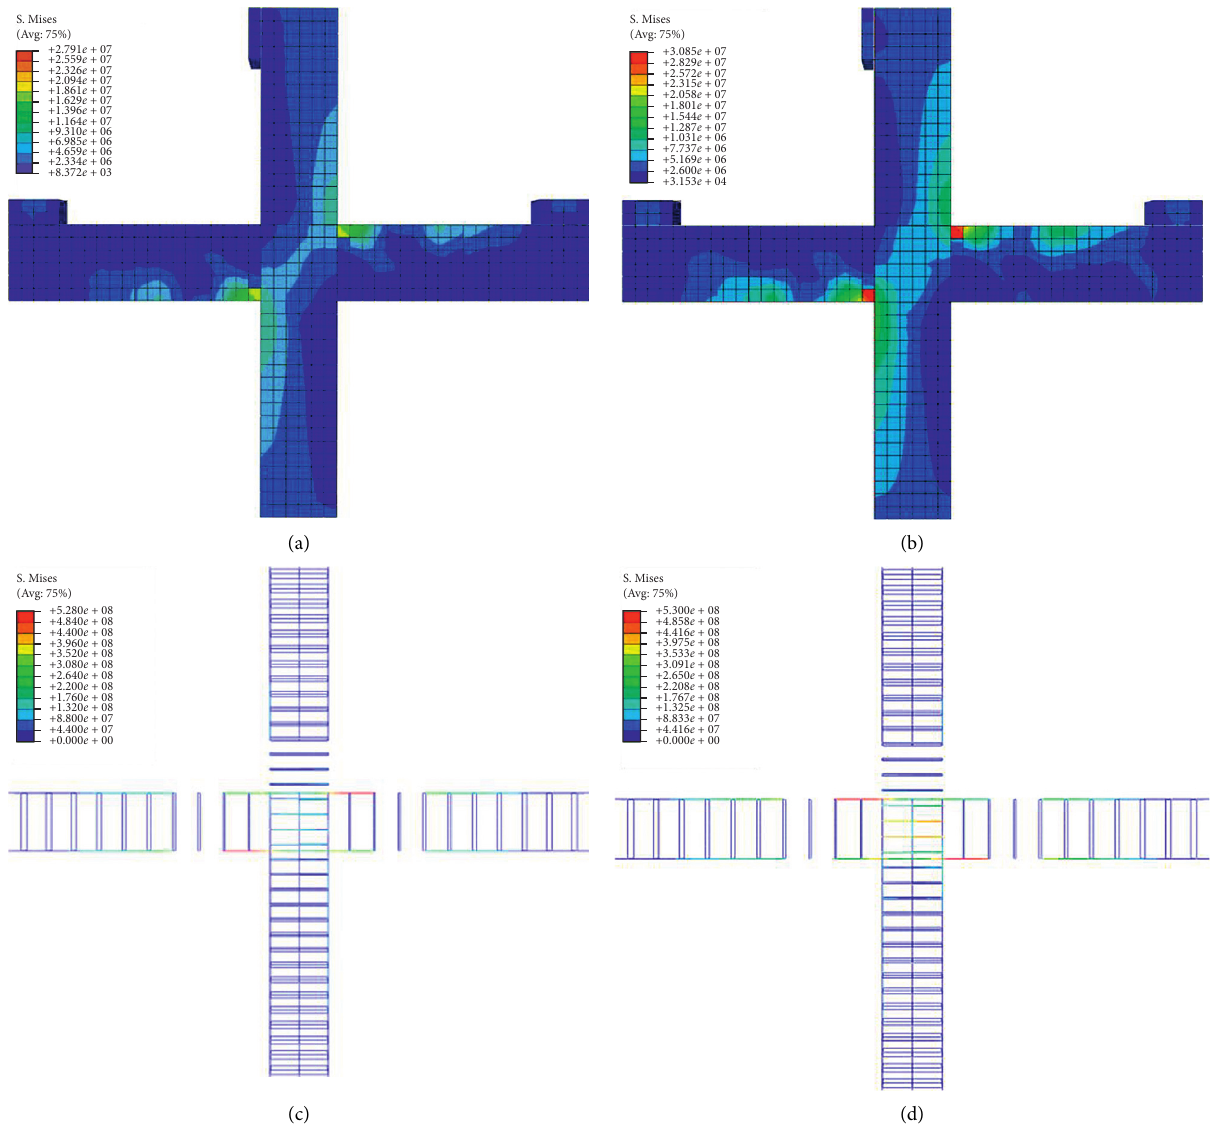
Figure 8: Mises stress nephogram of the finite element simulation. (a) The stress form of the Strut-and-Tie rod in the core area of the beam- column joint. (b) Concrete at beam ends is crushed. (c) Beam stress reinforcement begins to yield. (d) The core stirrups begin to